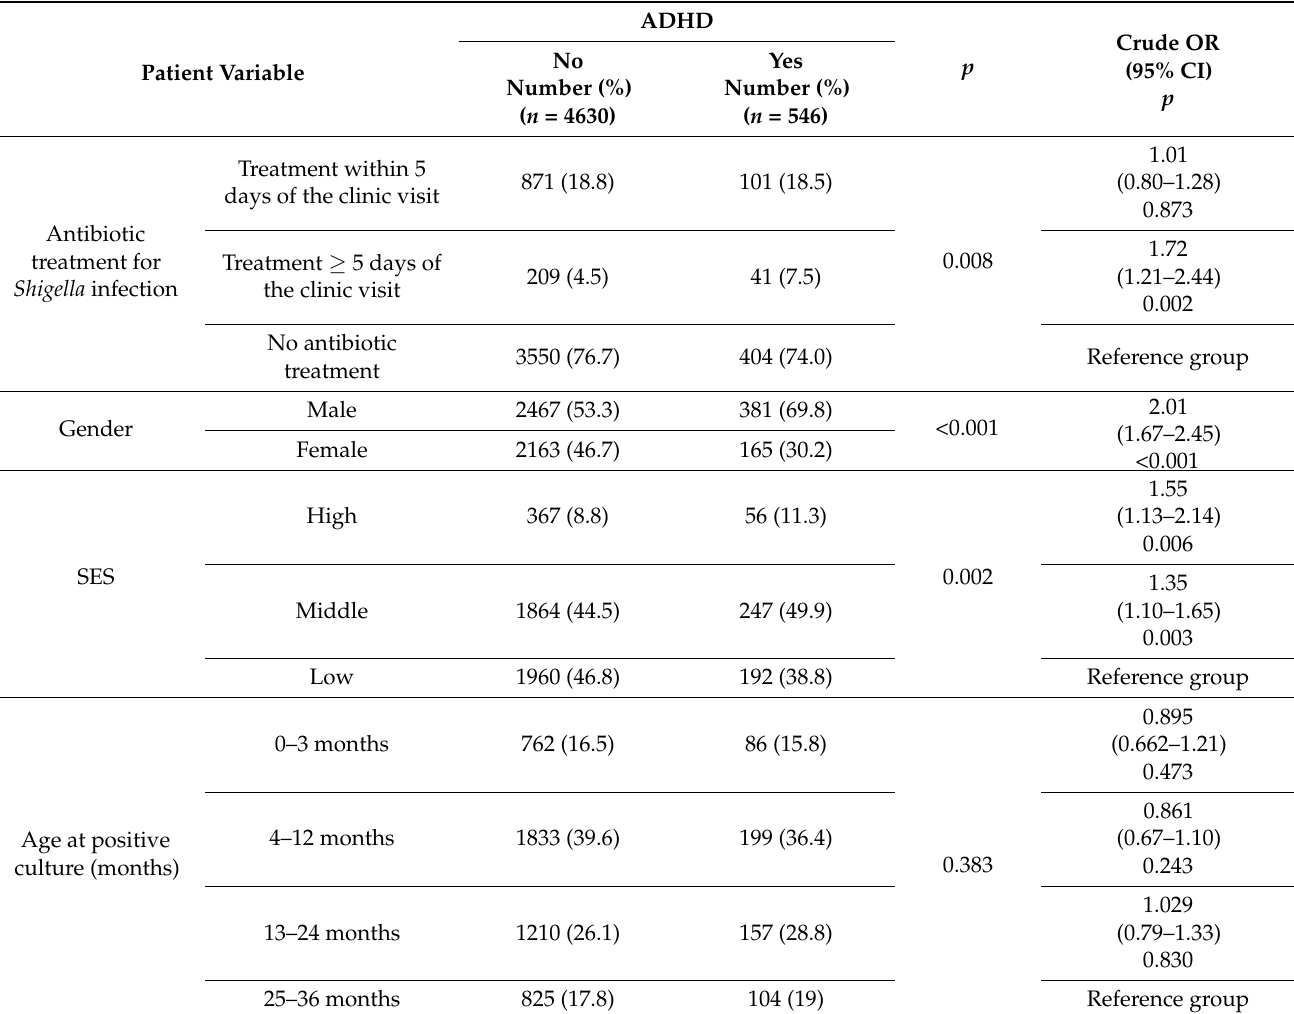
Table 2. Univariable analysis and crude odds ratio (OR) associating antibiotic treatment with Shigella gastroenteritis and ADHD ( n = 5176).